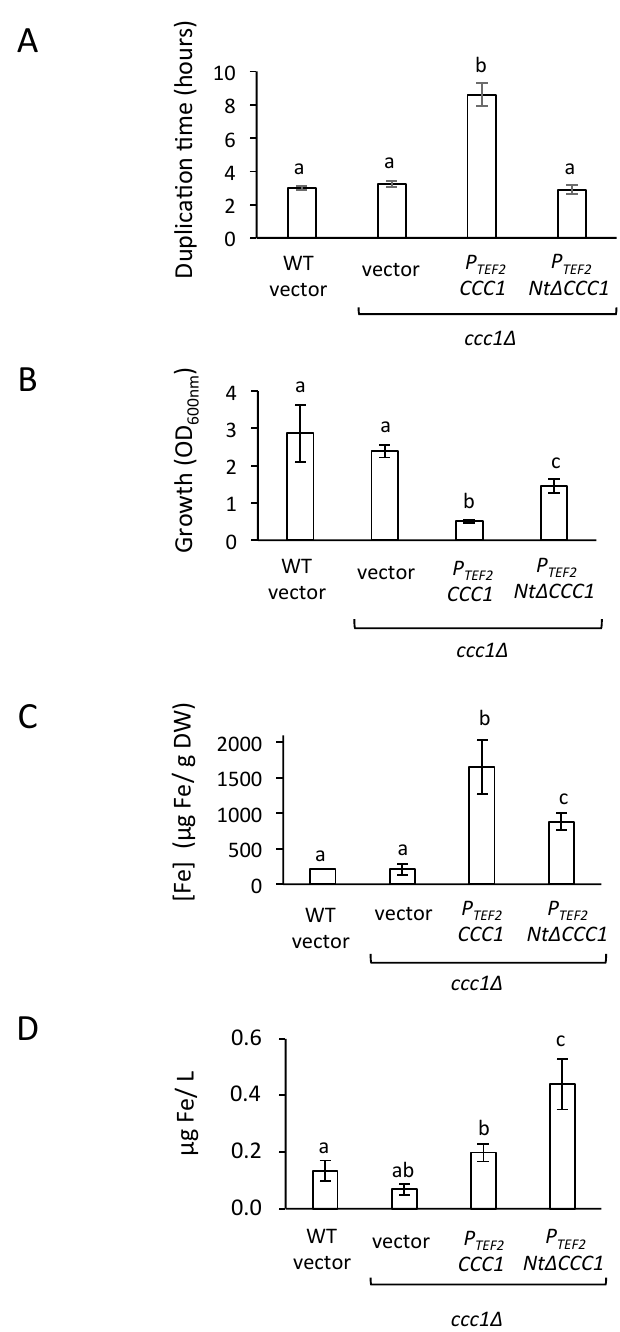
Figure 4. Overexpression of Nt ∆ CCC1 improves iron extraction from media. ( A ) Yeast cells described in Figure 2 were inoculated at an OD 600nm of 0.2 in SC-Ura with 500 µ M FAS in a 96-well microplate reader and duplication times were calculated from the resulting growth curves as described in Materials and Methods. ( B – D ) Yeast cells described in Figure 2 were cultivated in SC-Ura + 500 µ M FAS for 6 h, and OD 600nm ( B ), µ g Fe/g dry weight (DW) ( C ), and µ g Fe/L of medium ( D ) were determined. Three independent biological replicates were performed. The average and standard de- viation were determined. Different letters above the bars represent statistically significant differences ( p -value <